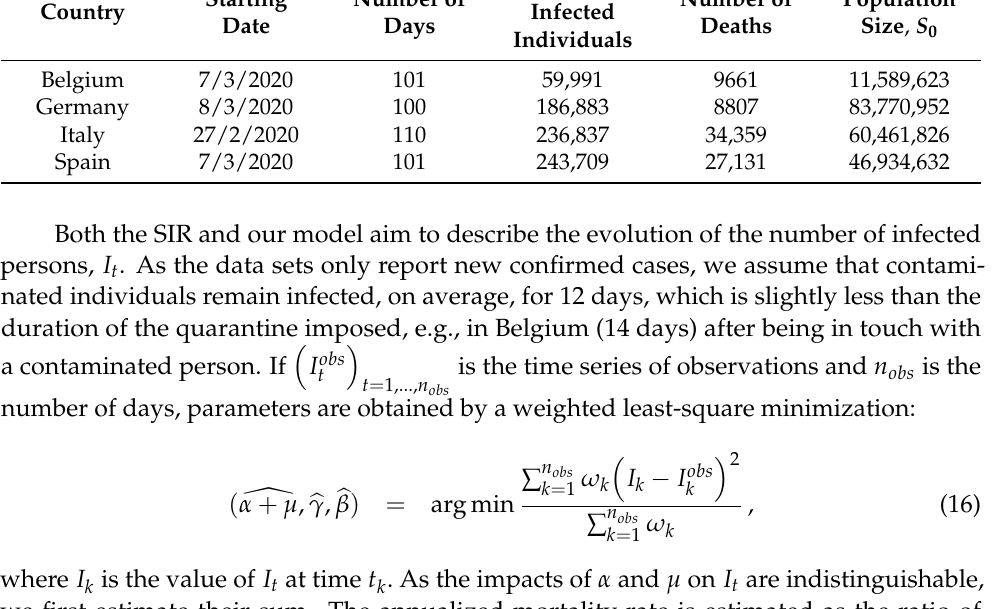
Figure 1. Graphs of the number of COVID-19 reported cases and deaths from March to June, for Belgium, Germany, Italy and Spain. Table 1. Statistics about the time series of deaths and confirmed COVID cases.